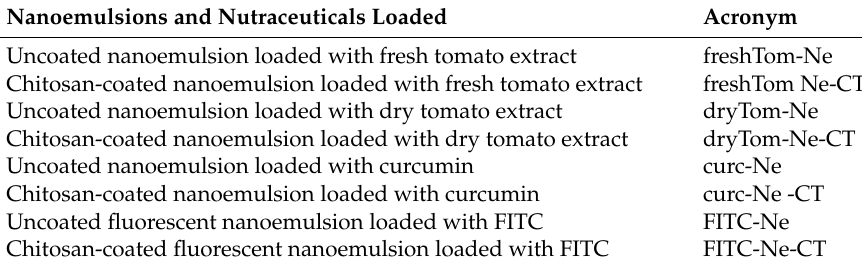
Table 1. The nutraceutical-loaded and fluorescent